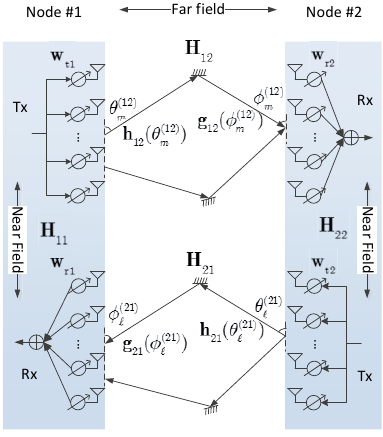
Figure 1. Illustration of the FD mmWave communication